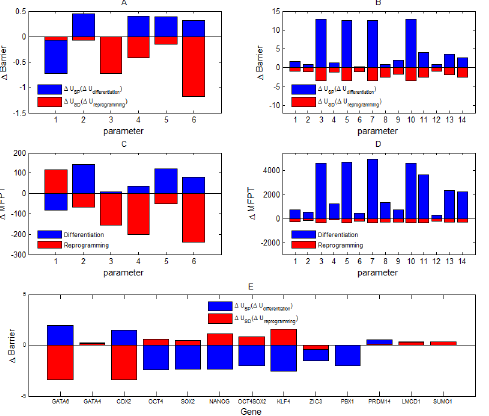
Figure 6. Results of the global sensitivity analysis in terms of barrier height and MFPT (mean first passage time) when parameters are changed. The results in (A) are for 6 repression links (named respectively as R1,R2,…,R6, see Table S2) based on the change of barrier heights ( D Barrier ). The results in (B) are for 14 activation links (named respectively as A1,A2,…,R14, see Table S3) based on barrier heights. Blue bars represent the change of U SP (barrier for differenti- ation process), red color represent the change of U SD (barrier for reprogramming process). (C) and (D) separately show the correspond- ing results in terms of the change of MFPT ( D MFPT ). Blue bars represent the MFPT change for differentiation process, and red bars represent the MFPT change for reprogramming process. (E) shows the corresponding global sensitivity for the knockdown of individual genes.